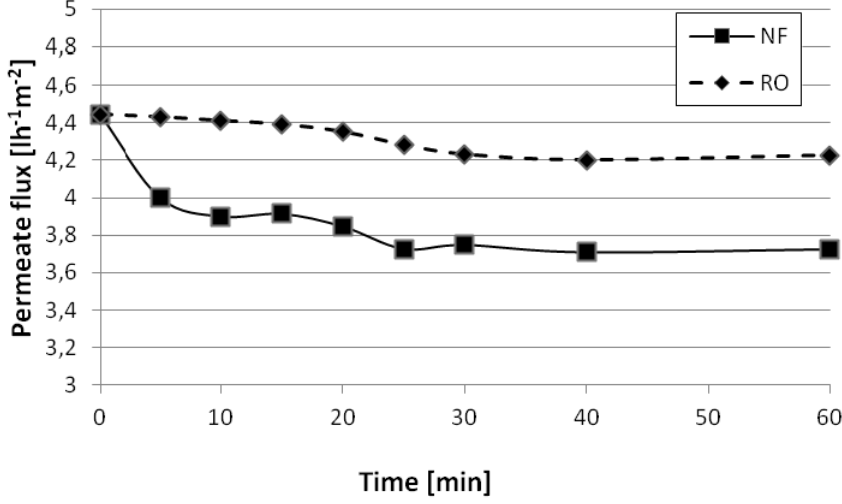
Figure 2. Profiles of the NF (full line) and reverse osmosis (RO) (dotted line) permeate fluxes during